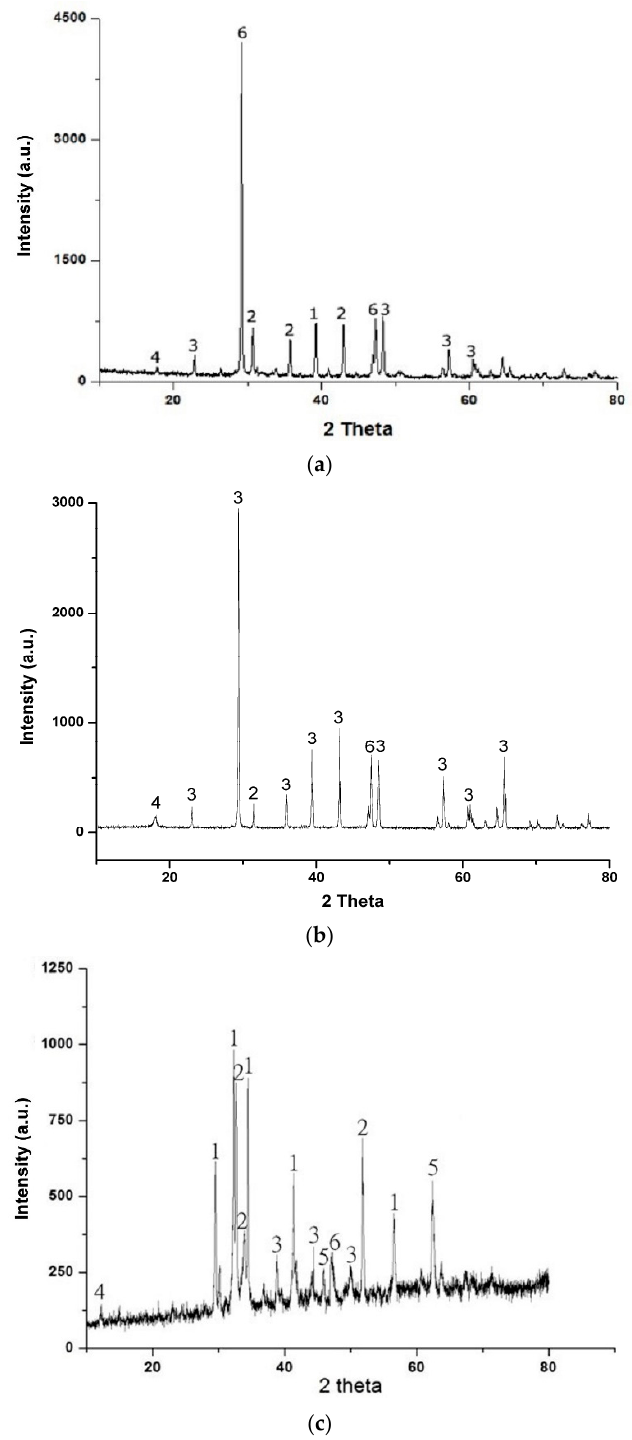
Figure 6. X-ray diffraction (XRD) spectrogram of concrete: ( a ) BT, ( b ) B15% and ( c ) B25%. The spectrograms obtained were treated using X’Pert High Score software to deter- mine crystalline phases using ICDD “International Centre for Diffraction Data” cards (See Table